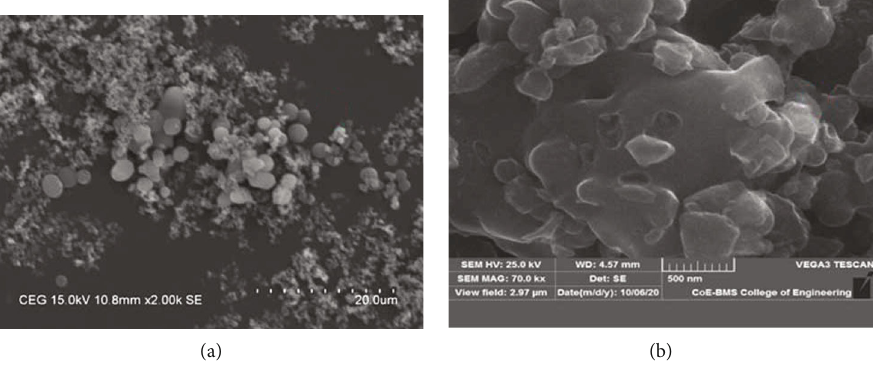
Figure 2: (a, b) SEM analysis projecting morphology of CS and